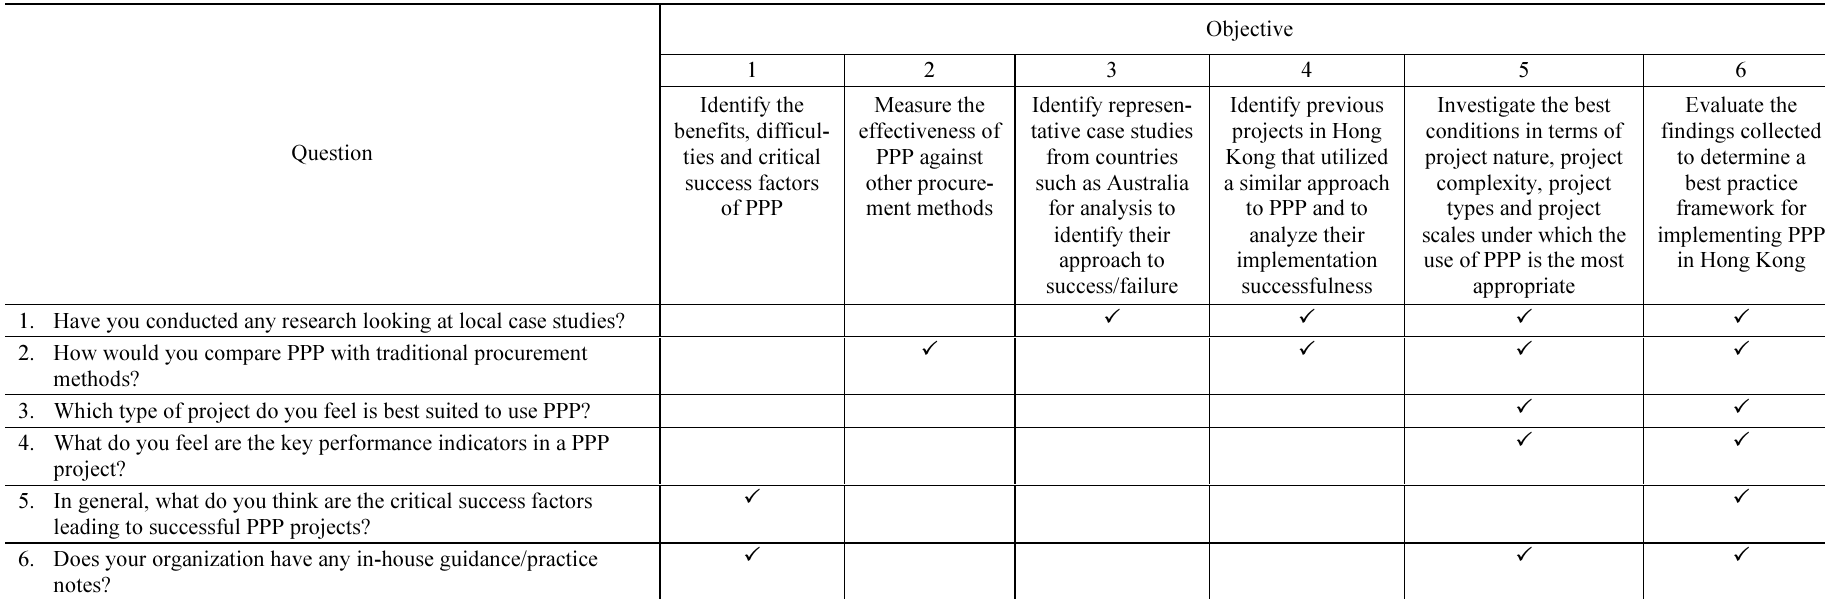
Table 2. Project objectives linking up with interview questions